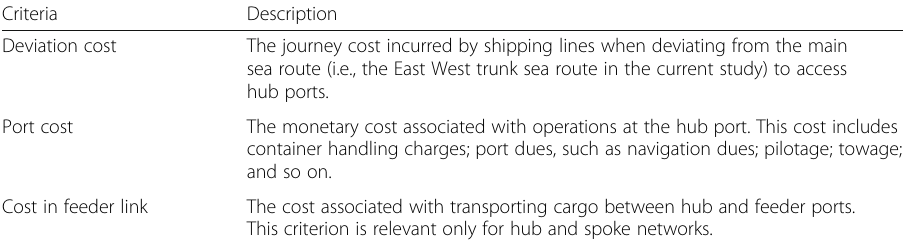
Table 2 Criteria Related to the Monetary Category Criteria